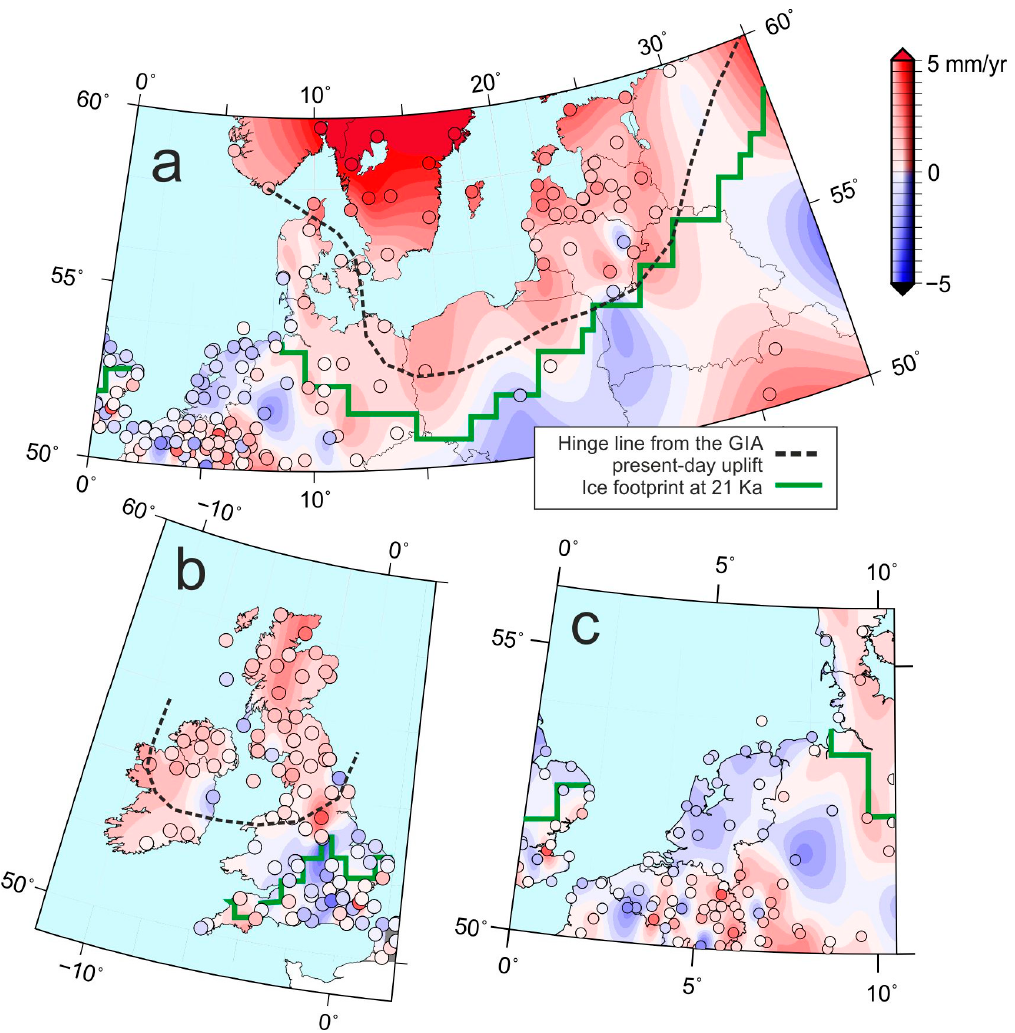
Figure 9. The GPS-derived vertical rates plotted as colored dots along with the GIA-predicted hinge line and the ice footprint at the time 21 Ka adapted from the ICE-6G GIA model. The GPS-derived velocities are interpolated to cover the entire area we examine. Individual maps show eastern Europe ( a ), the British Isles ( b ) and western Europe ( c ).